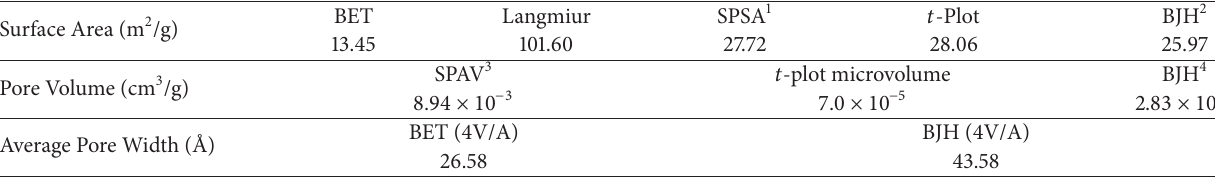
Figure 1: XRD spectra of B. Table 1: Some physical results of BET surface analysis of pretreated fish bone.